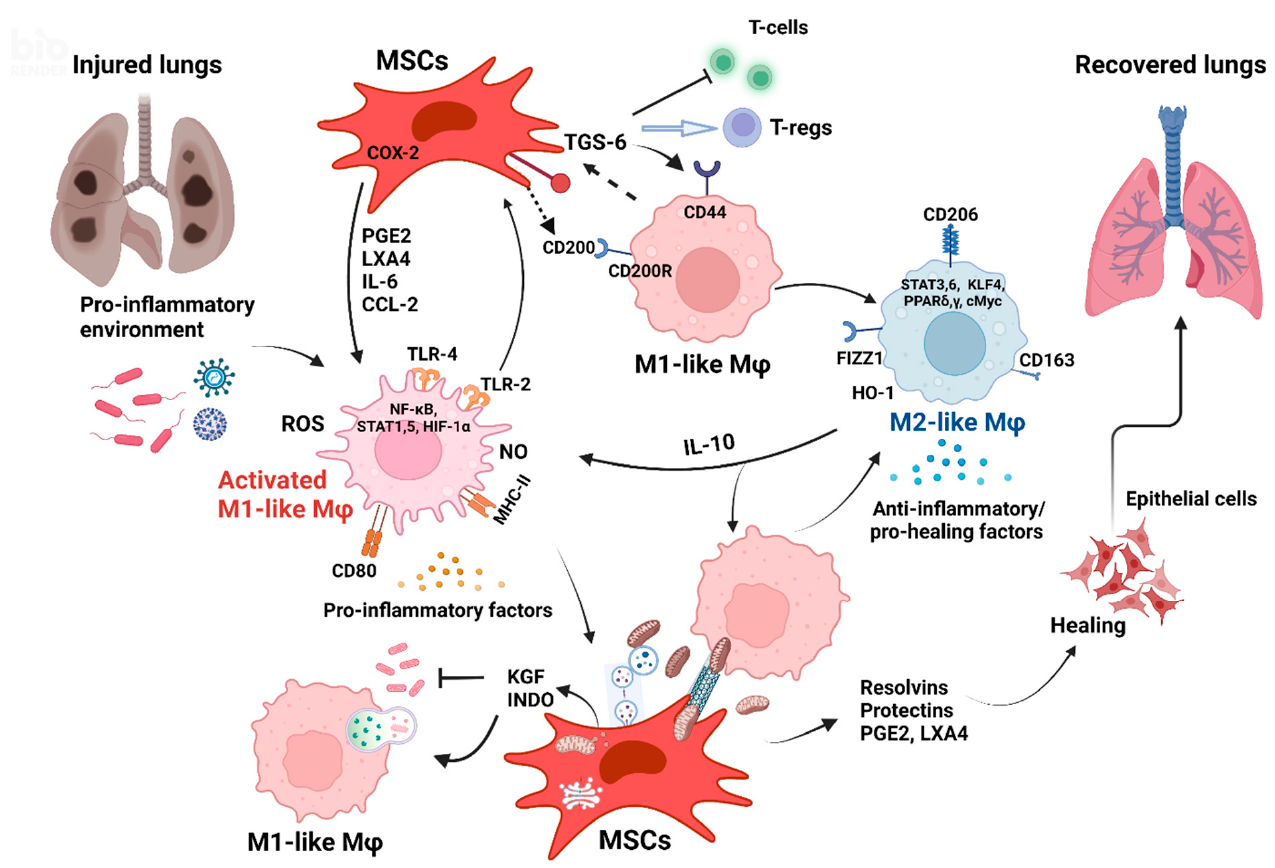
Figure 2. Crosstalk between MSCs and M ϕ s is crucial for lung injury recovery. (Created with BioRender.com.)